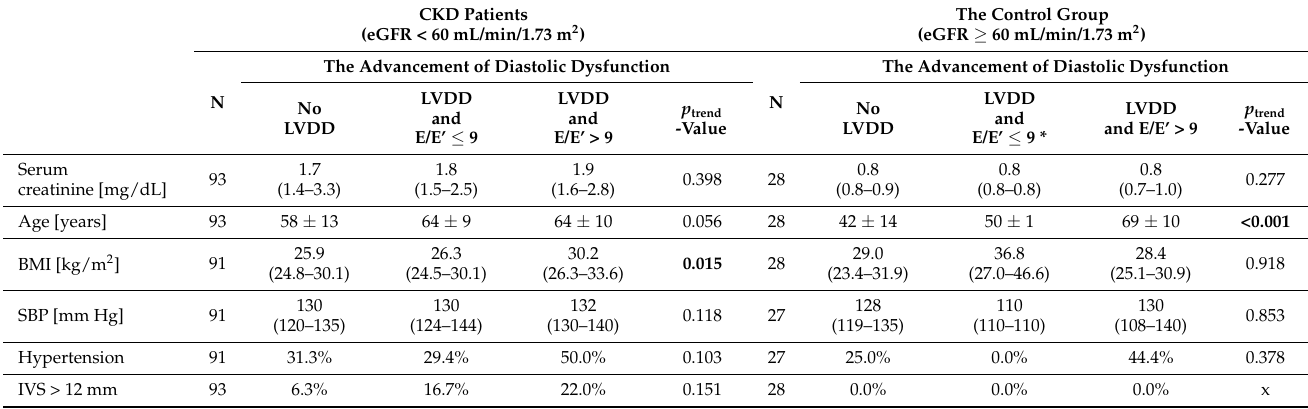
Table 3. Advancement of diastolic dysfunction according to elevated E/E’ value and metabolic, nutritional and inflammatory parameters in CKD and non-CKD